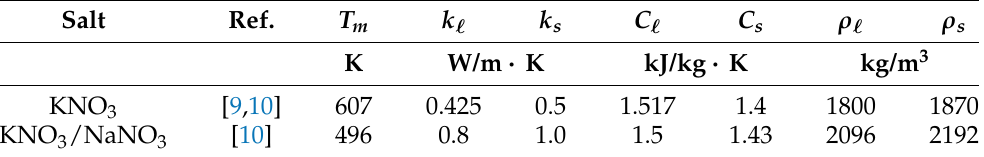
Table 1. Thermodynamic properties of KNO 3 and KNO 3 /NaNO 3 salts. Specific heat capacity values for the liquid and solid phase are close to the melting temperature of the